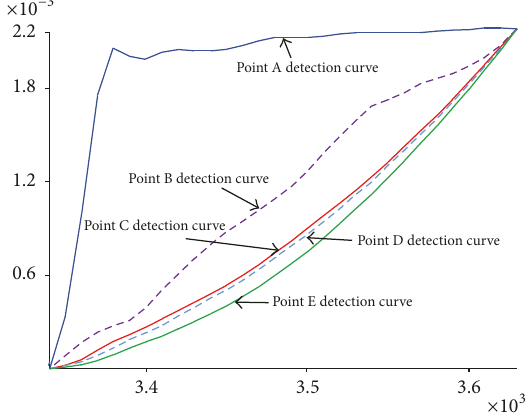
Figure 17: Measured horizontal shift of monitoring